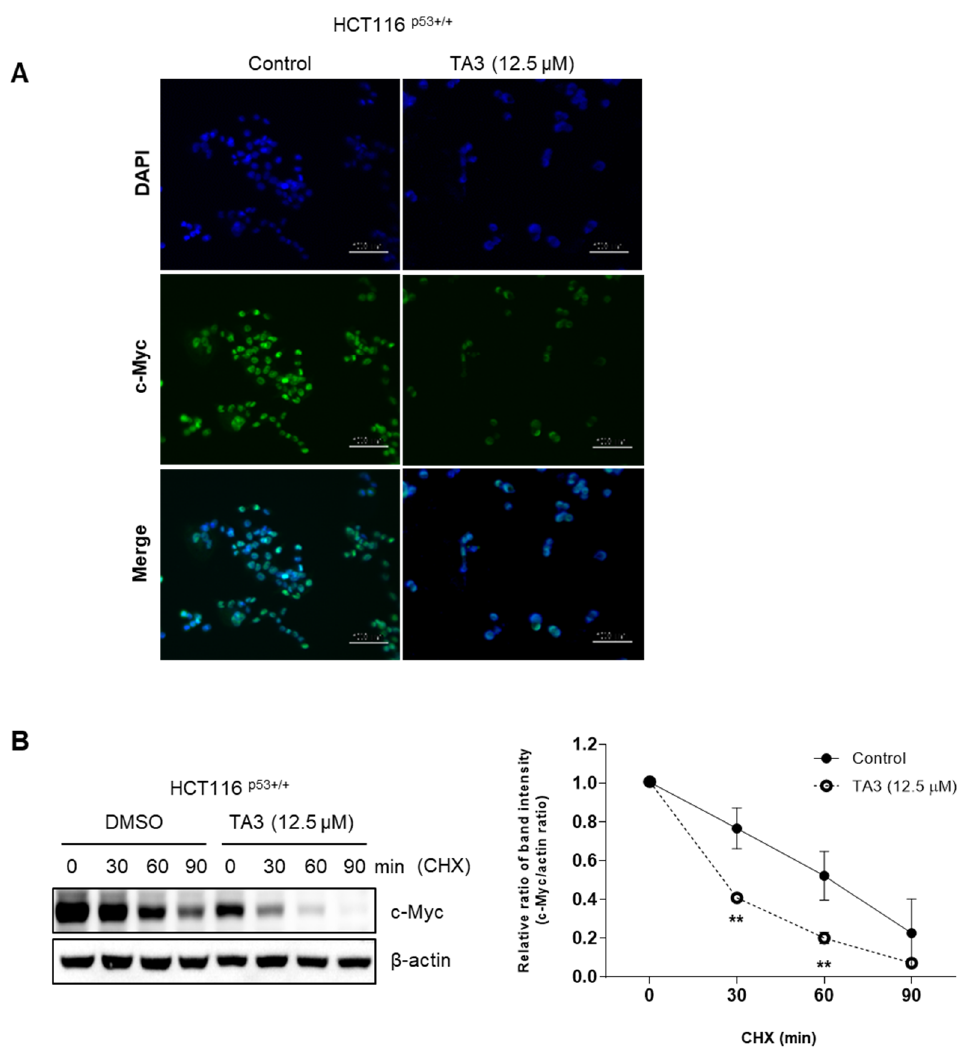
Figure 3. TA3 reduced c-Myc protein stability. ( A ) Cells were treated with TA3 (12.5 μM) for 24 h. Then, cells were fixed with 4% paraformaldehyde and labeled with c-Myc antibody. Images are magnification 200 ×, scale bar 100 μm. ( B ) Effect of cycloheximide (CHX) on the c-Myc expression in TA3-treated HCT116 p53+/+ cells. HCT116 p53+/+ cells were treated with TA3 (12.5 μM) for 24 h, and then exposed to 50 μg/mL CHX at different time points. Statistical significance was analyzed using the unpaired t-test. p-values indicate a significant difference between the groups. Quantification of protein expression is shown in the right panel. ** p < 0.005 vs. control.